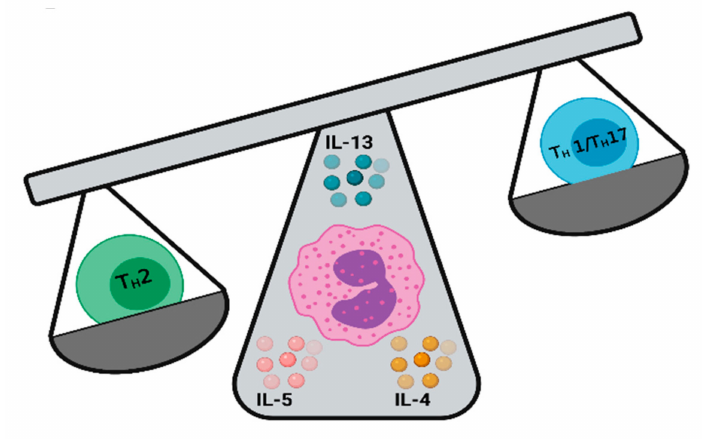
Figure 1. Eosinophils promote T H 2 responses. Eosinophils responding and secreting cytokines, such as IL-4, IL-5, IL-13 and others, generates a type II immune response that can promote the generation of T H 2